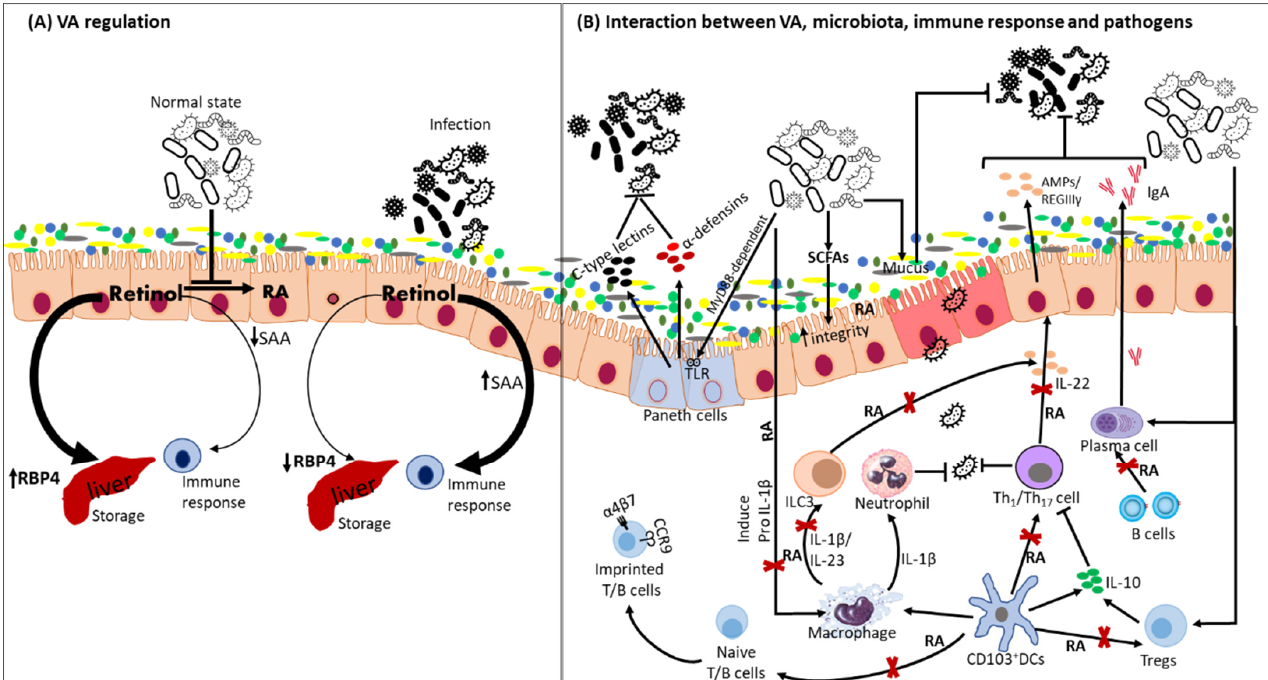
Figure 1. Multidirectional relationship between VA, gut microbiome, immune response and infections. ( A ) In normal state, the beneficial gut microbiome promotes RA storage via suppressing conversion of dietary retinol into retinoic acid (RA), hence increasing retinol transporter retinol binding protein 4 (RBP4) and reducing acute-phase RBPs (serum amyloid A (SAA)). However, during infection, RBP4 amounts decrease, resulting in low circulating retinol and low hepatic storage, while SAA levels increase, leading to upregulation of local immune response to infection. ( B ) Beneficial microbes upregulate the host epithelial barrier function by production of mucus and short-chain fatty acids (SCFAs), and the microbiota stimulates secretion of IL-1 β , leading to elevated neutrophil recruitment to infection site, promoting secretion of IL-22 and resulting in release of antimicrobial peptides. Commensals also act through MyD88-dependent mechanism to trigger production of antimicrobials (AMPs) such as α -defensins, C-type lectins and REGIII- γ by Paneth cells. Beneficial microbes promote adaptive immunity by stimulating Th1 and Th17 cells, leading to increased production of IL-22. Finally, the microbiome prevents pathogen colonization by regulating the secretion of IgA by plasma cells and differentiation of T regulatory cells. VA through its metabolite RA is essential in strengthening host–barrier integrity, enhancing innate immune response and modulating adaptive immunity (effect indicated by arrows). Following antigen stimulation, CD103 + DCs in gut-associated lymphoid tissues (GALT) produce RA that imprints gut-homing specificity on T and B cells expressing both α 4 β 7 and CCR9, which migrate to small intestine tissues and bind to MAdCAM-1 and CCL25, respectively. The X (red) in the arrows indicates immune response pathways affected when the host is deficient in VA